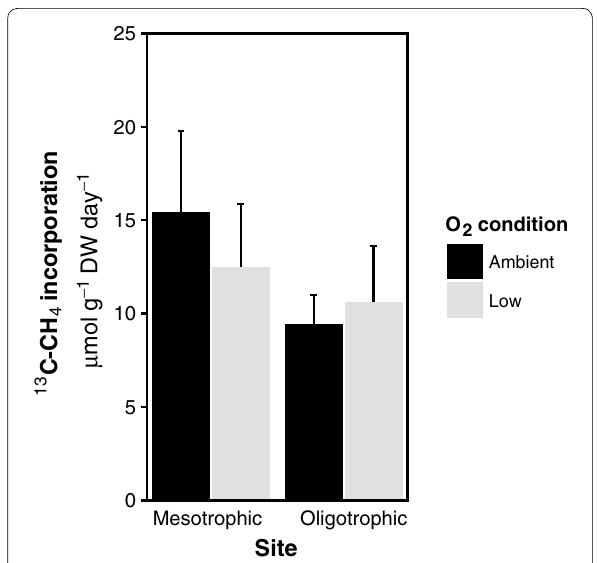
Fig. 2 Incorporation of 13 C–CH 4 (μmol g − 1 DW day − 1 ) in Sphagnum mosses from mesotrophic fens and oligotrophic fens and bog sites, incubated with ambient O 2 conditions (dark grey bars) or low O 2 conditions (light grey